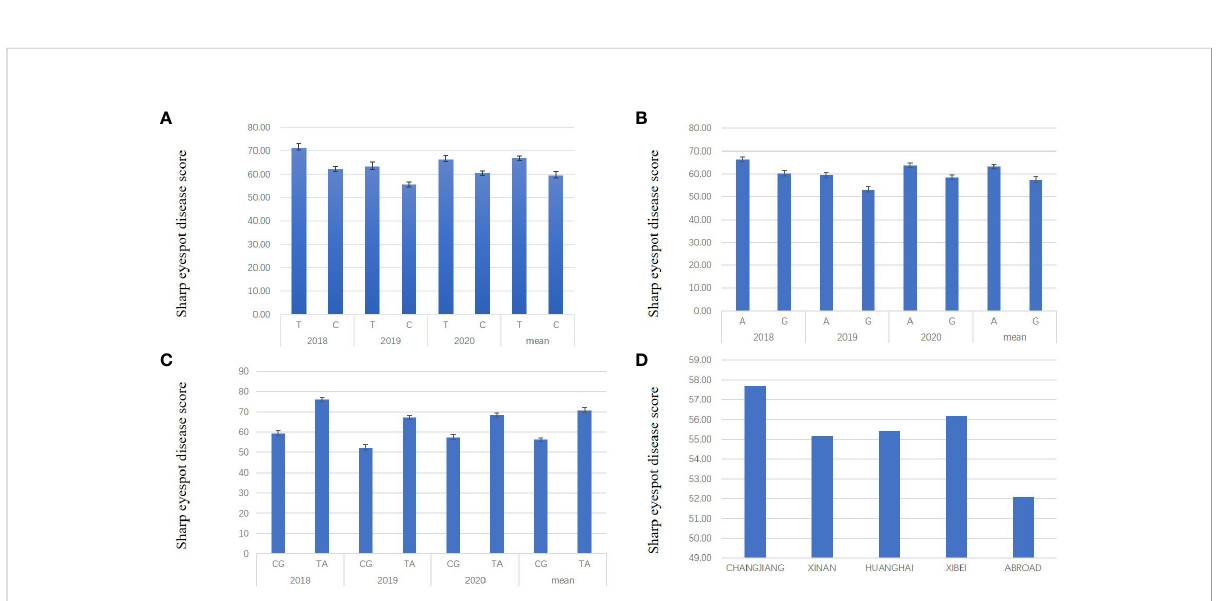
FIGURE 3 Resistance effects and ‘ CG ’ haplotype distribution of qSE-6A and qSE-7B. (A) , Effects of the favorable allele ‘ C ’ of SNP BS00078658_51 (represent qSE-6A ) versus the unfavorable allele ‘ T ’ . (B) , Effects of the favorable allele ‘ G ’ of SNP wsnp_Ex_c3501_6407527 (represent qSE-7B ) versus the unfavorable allele ‘ A ’ . (C) , Effects of the favorable haplotype ‘ CG ’ of SNP BS00078658_51 and wsnp_Ex_c3501_6407527 compared to the unfavorable haplotype ‘ TA ’ . (D) the ratio of ‘ CG ’ haplotype varieties in each wheat